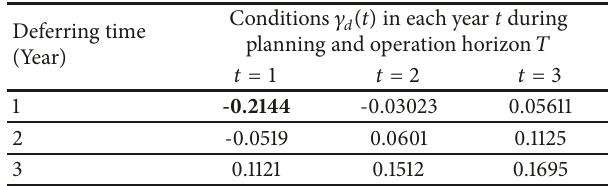
Table 9: Conditions for deferring this railway project in Scenario 5.